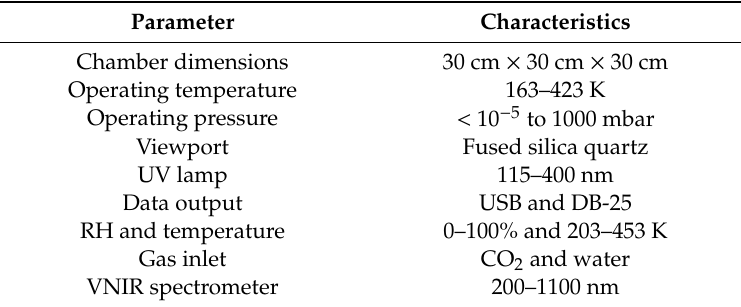
Table 1. Specifications of